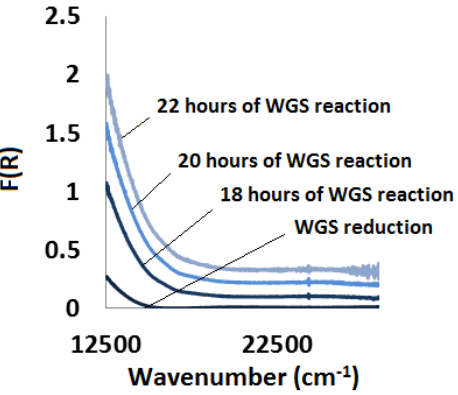
Figure 11. In situ Kubelka-Munk spectra for the 1La catalyst under WGS reaction. The Kubelka-Munk values are higher than the values obtained during TPR experiments.